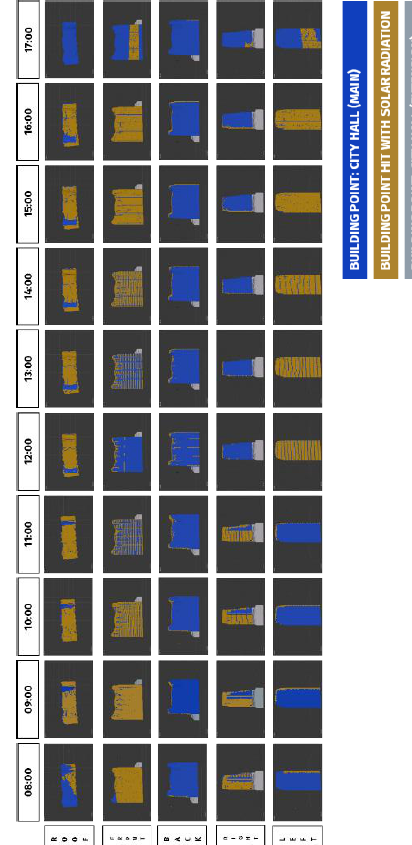
Figure 14. Screenshots of the Solar Radiation Model Visualized